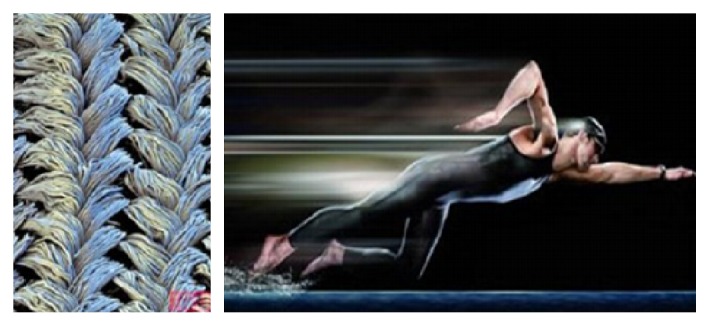
Bionic swimsuit.